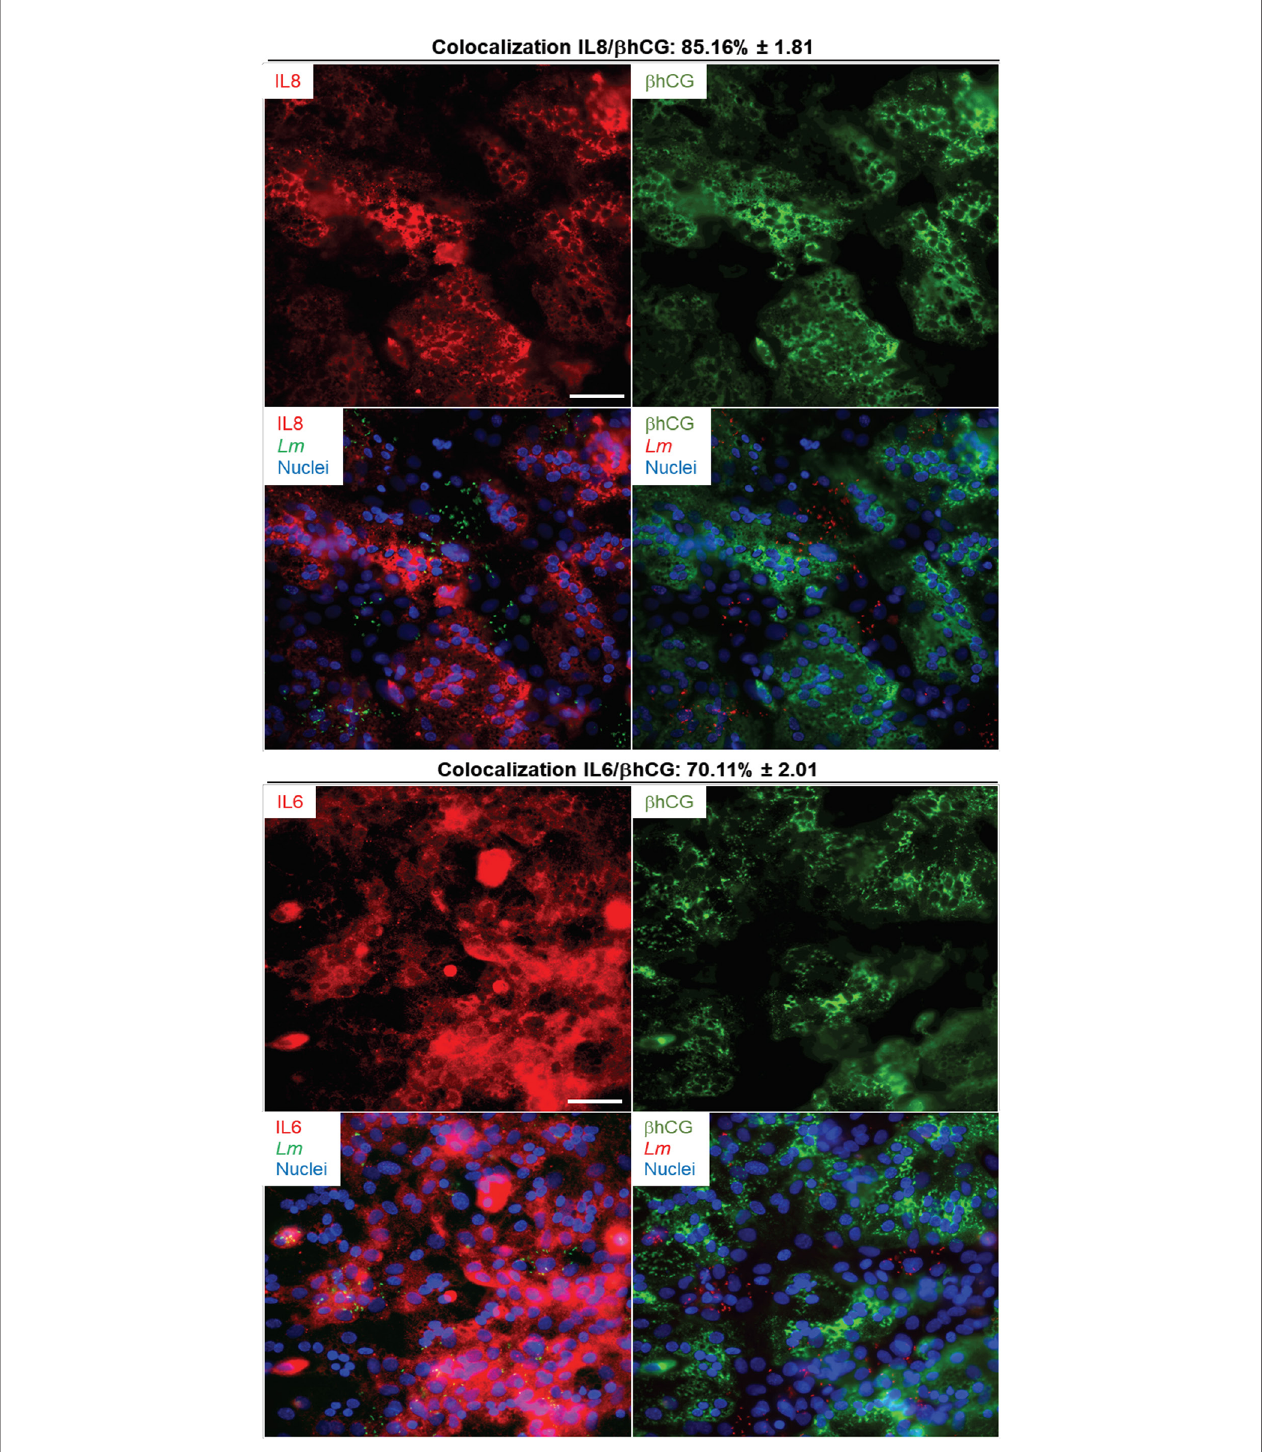
FIGURE 6 | IL-6 and IL-8 colabeling with b hCG in infected primary trophoblasts. PHT were infected with p actA -RFP L. monocytogenes (MOI 1) for 5 h using the same experimental procedure as the RNAseq infection experiments. Cells were fi xed, permeabilized and labeled for IL-6 (mouse primary Ab and secondary Ab-Alexa Fluor 647), IL-8 (mouse primary Ab and secondary Ab-Alexa Fluor 647), b hCG (rabbit primary Ab and secondary Ab-Alexa Fluor 488), and nuclei were labeled with DAPI. At least thirty fl uorescent images were randomly acquired with the 40X objective. Representative images are from one experiment. Scale bar = 50 µm. The Metamorph software was used to measure the percent colocalization between each cytokine and, b hCG the average colocalization ± SEM is indicated at the top of the